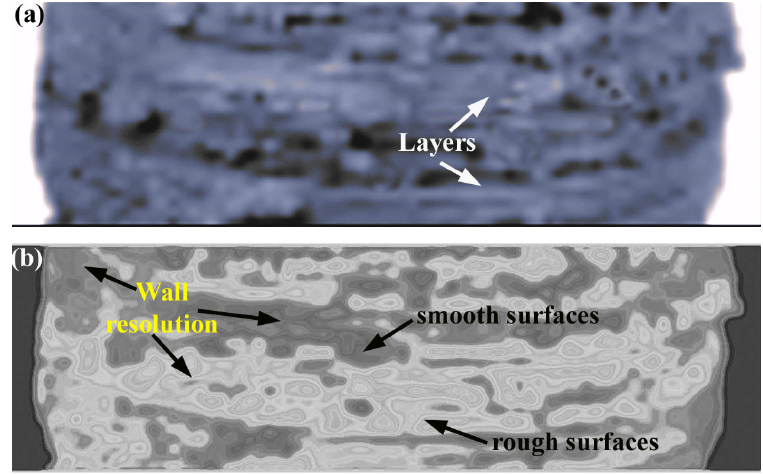
Figure 14. Solid state additive manufacturing of dissimilar layers ( a ) as deposited, ( b ) wall resolution processed condition.